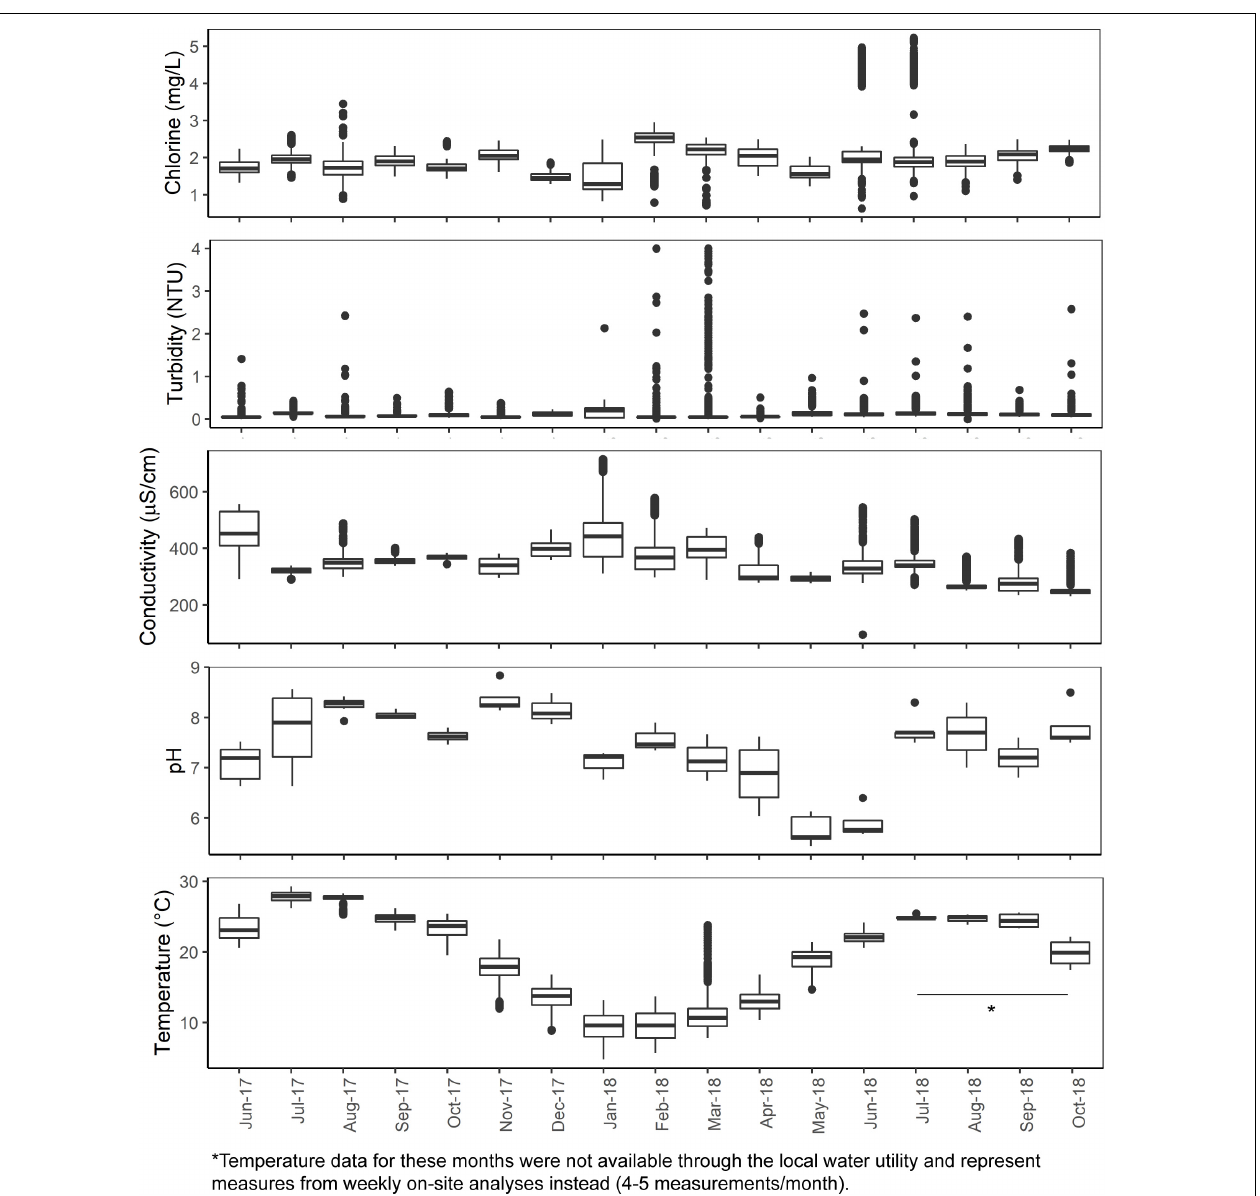
FIGURE 1 | Total chlorine, turbidity, temperature, conductivity (5-min data provided by the local water utility) and pH and temperature (analyzed weekly on-site) of the AR influent water from June 2017 to October